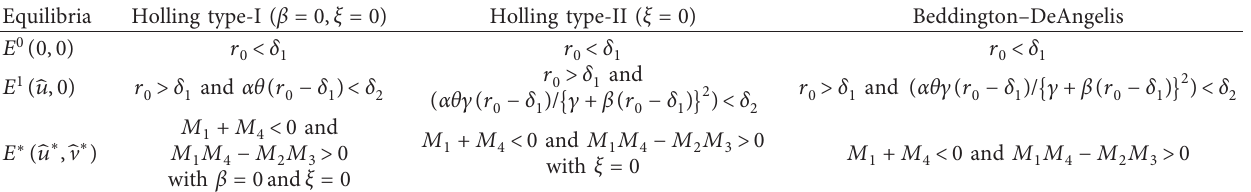
Table 1: Stability conditions for different equilibrium points of system